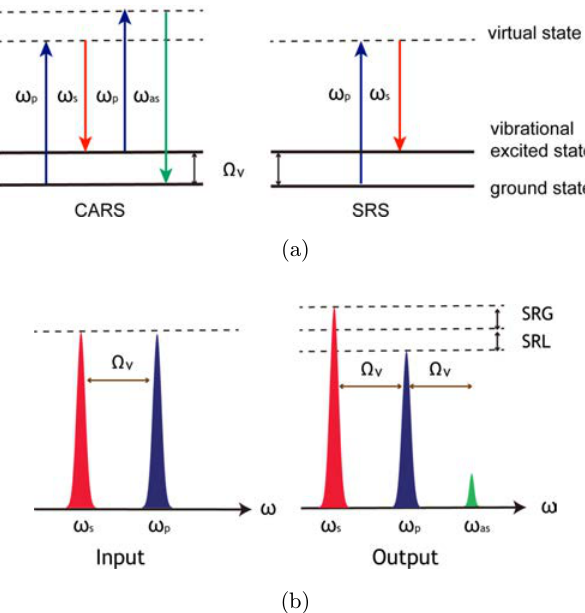
Fig. 1. Principles of CRS: (a) Energy diagrams of CARS and SRS, and (b) intensity and frequency changes in CARS and SRS